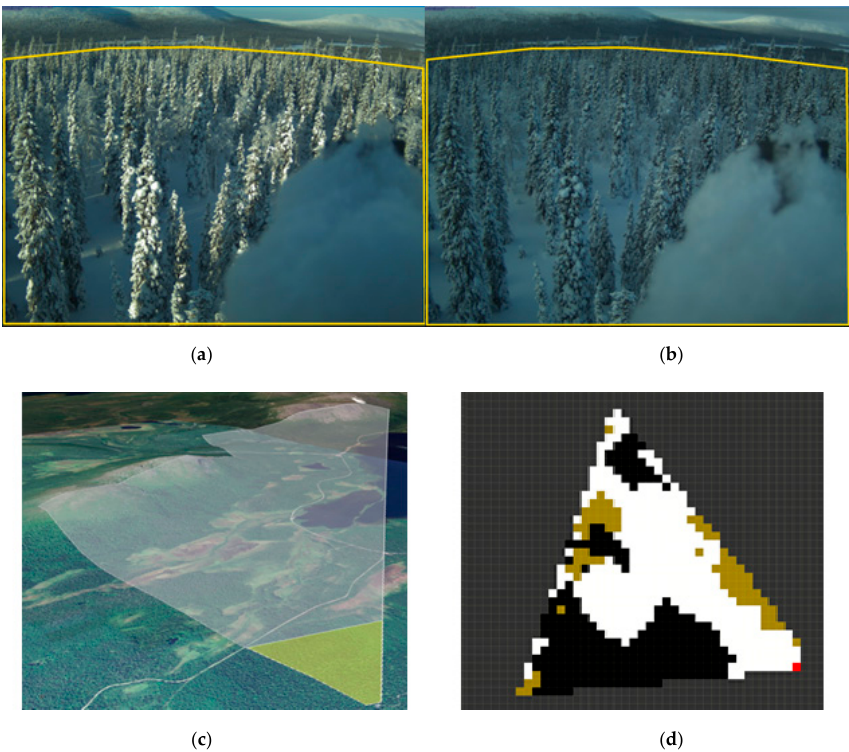
Figure 9. AOI for Kenttärova canopy camera and S-2 snow cover map over the AOI for 18 February 2018–( a ) AOI marked on the camera image at 09:00 (yellow polygon); ( b ) AOI marked on the camera image at 11:00 (yellow polygon); ( c ) Approximate FOV of the camera (white polygon) and AOI (yellow polygon) in Google Earth; ( d ) Extracted snow cover map from S-2 image at 10:10 (white: snow; brown: no-snow; black: clouds and unclassified; red: camera location). AOI is approximately 0.25 km 2 , corresponding to 633 S-2 pixels.